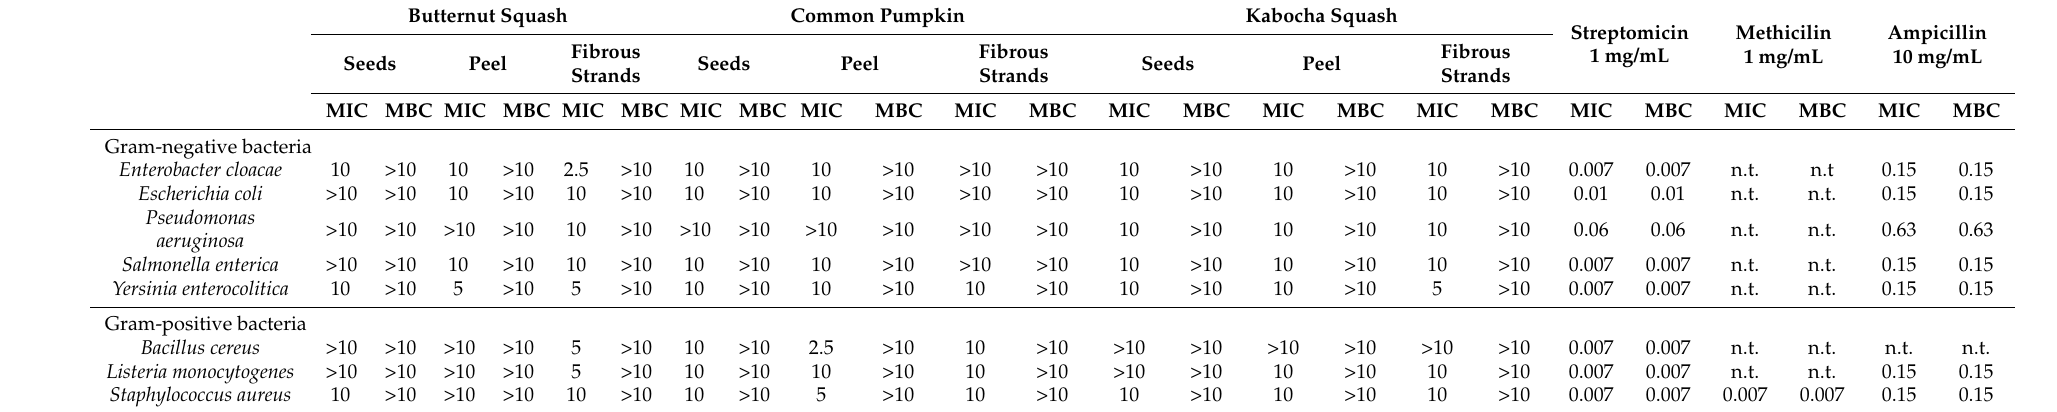
Table 6. Antibacterial activity of the byproducts of three pumpkin genotypes from Portugal. Butternut Squash